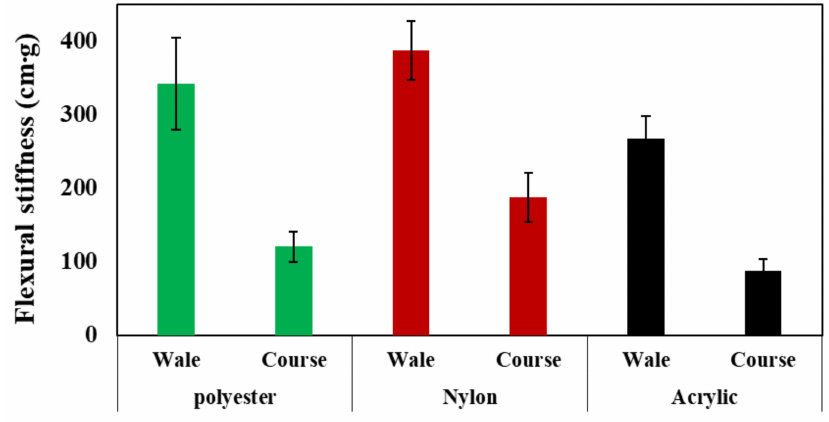
Figure 8. The flexural stiffness according to fabric direction.